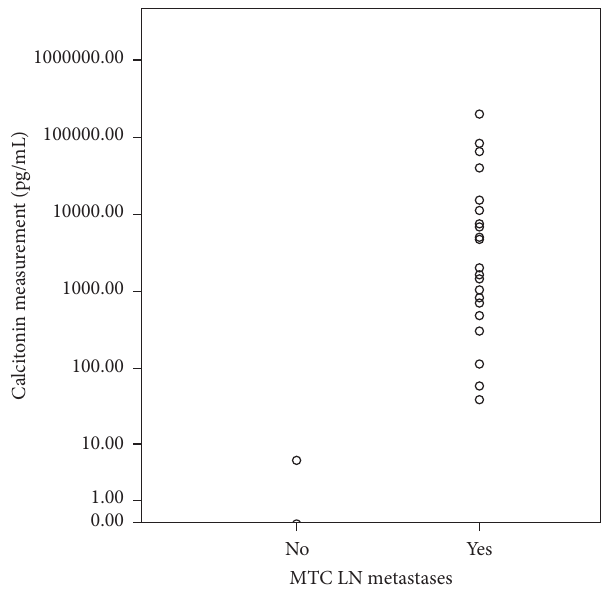
Figure 1: Distribution of MTC LN metastases according to FNA-CT measurements.